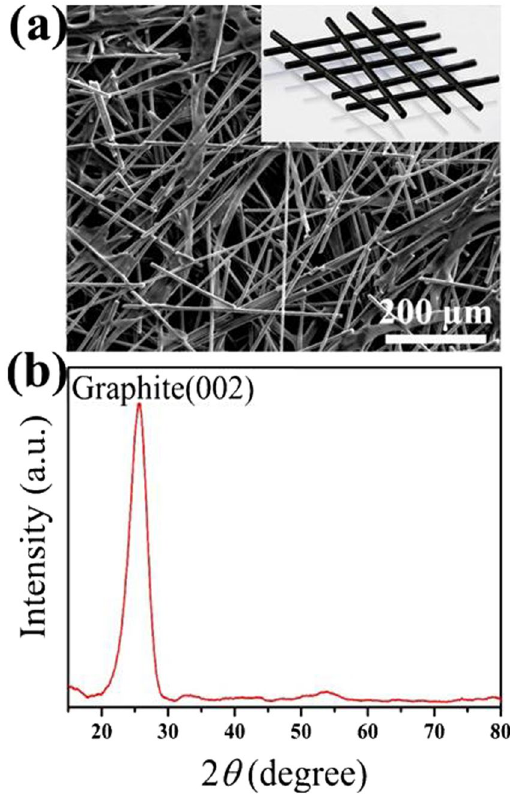
Figure 2. ( a ) SEM image and ( b ) XRD spectra of the pristine CFP. Inset in panel (a): Schematic illustrating the interpenetrating 3D network structure of